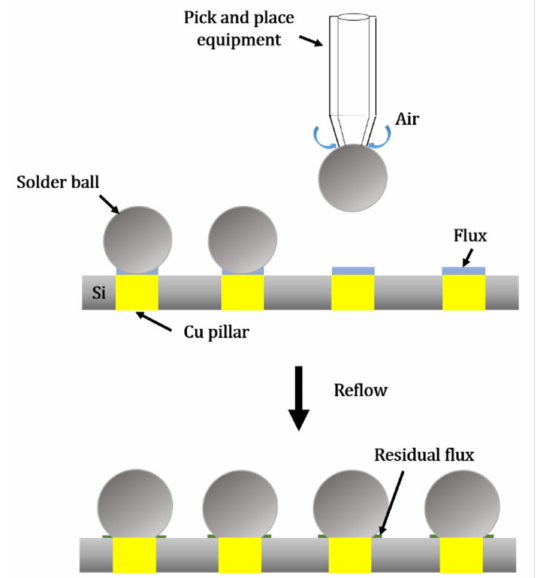
Figure 20. Schematic illustration of solder ball